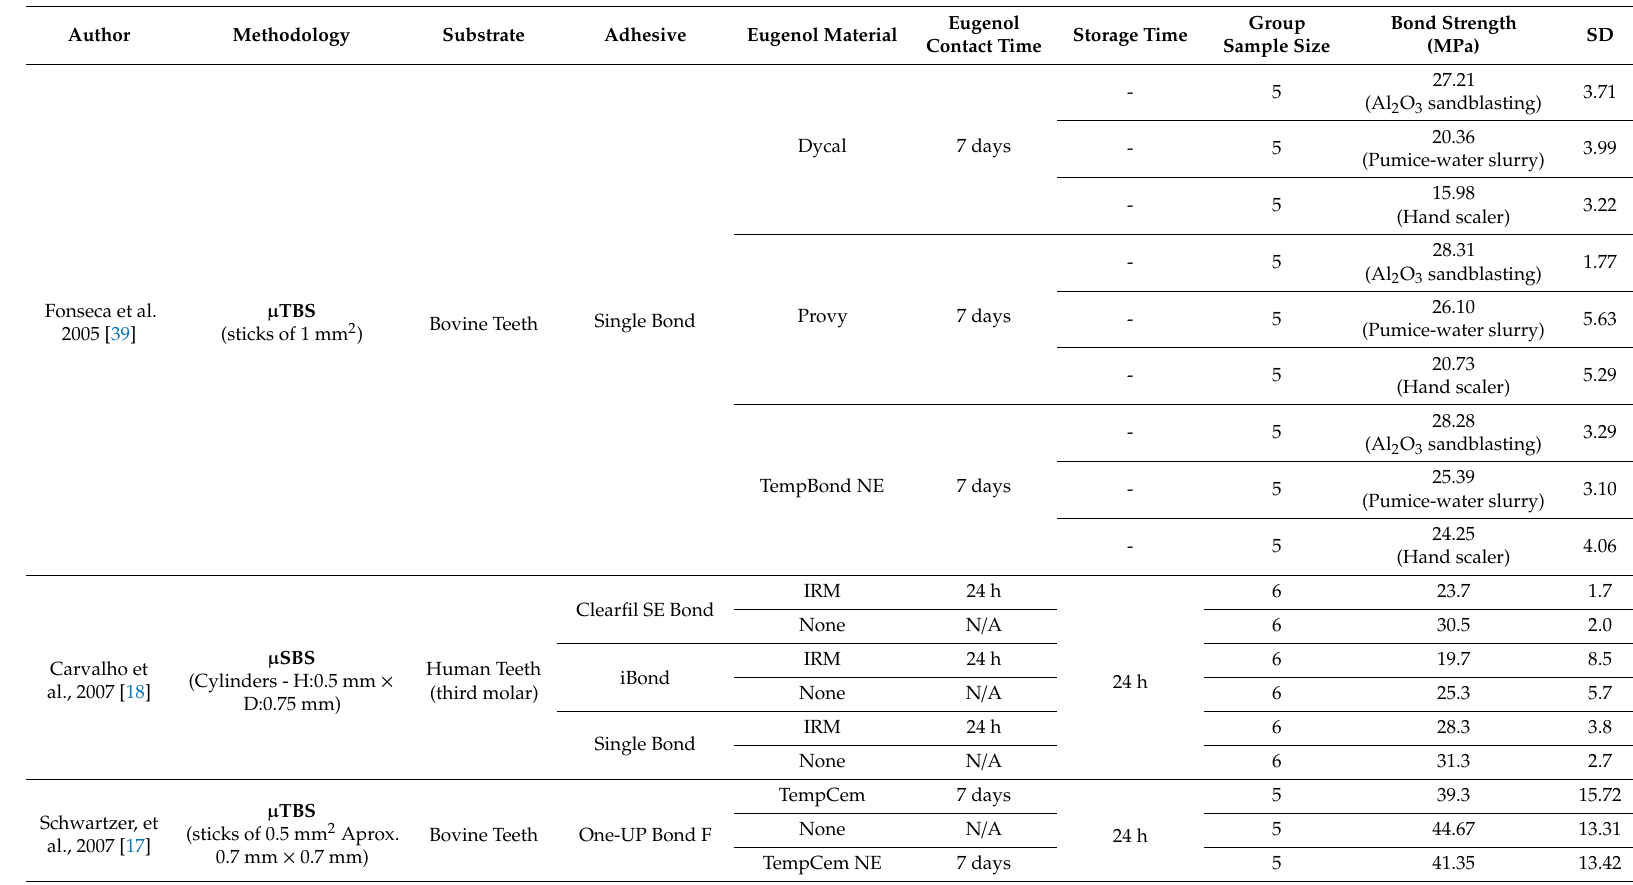
Table 1. Identification and characteristics of the included